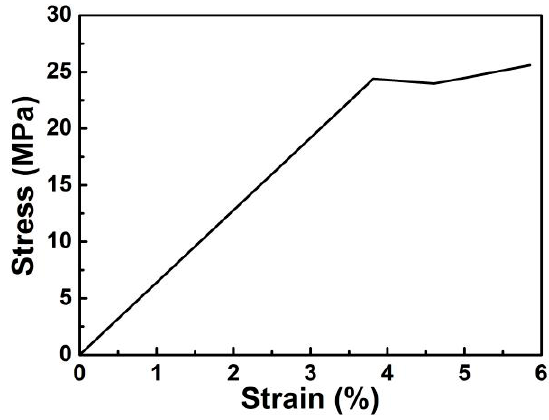
Figure 7. Stress-strain curve of the PAN-based gel polymer electrolyte.